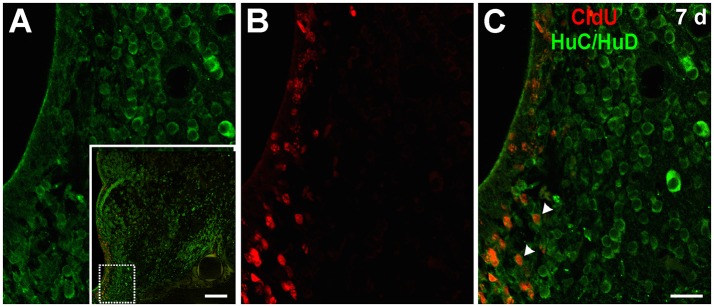
Neuronal differentiation in the subpallium at 7 days after the administration of a pulse of CldU demonstrated by co-localization with HuC/HuD. (A) Confocal microphotographs of the ventricular lining at the region of the rostral subpallium indicated by the rectangle in the panoramic view (inset). HuC/HuD and CldU labeling are shown in green and red channels in the microphotographs of a single plane shown in (A,B), respectively. The overlay of both channels is shown in (C). Arrowheads indicate CldU labeled retaining cells also expressing the neuronal marker HuC/HuD. Scale bars: (inset) 100 μm; (A–C) 20 μm.